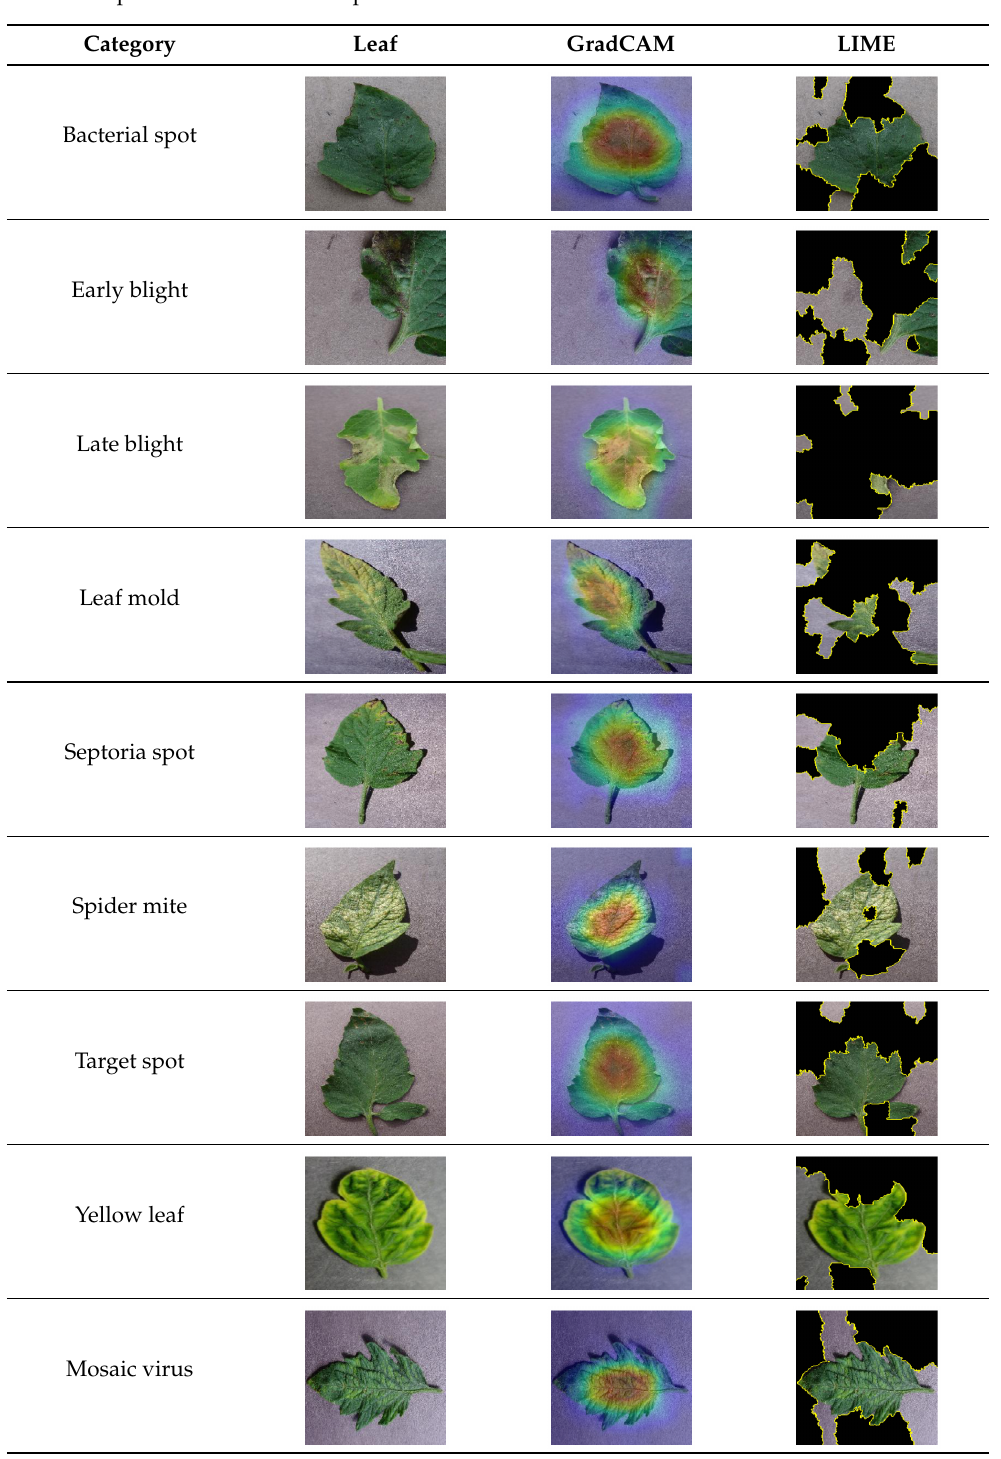
Table 5. Explainable AI result interpretations for